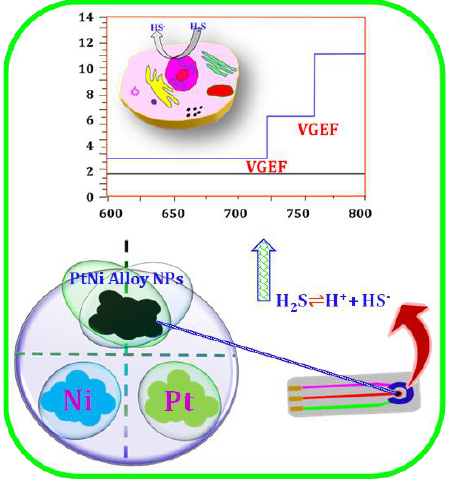
Scheme 1. Schematic representation of PtNi alloy NP formation and electrochemical detection of H 2 S in a human breast cancer cell.